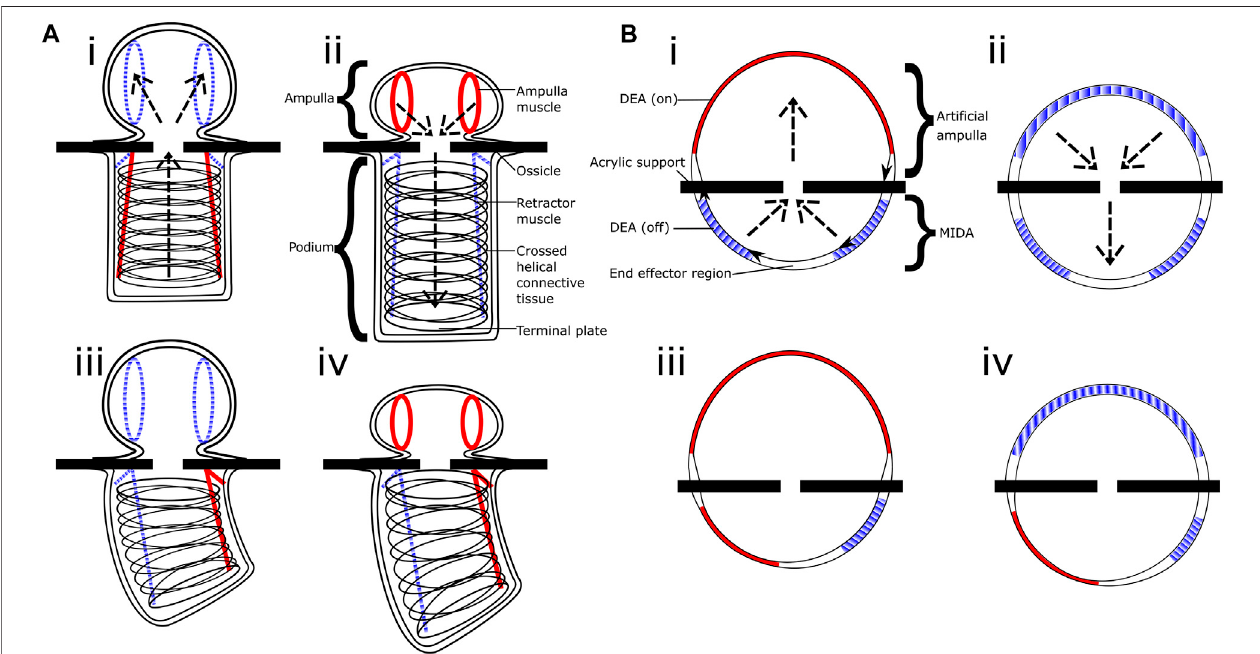
FIGURE5| Comparativediagram. (Ai – iv) showsthebasicstructureandmotionsofthetubefootof AsteriasRubens thecommonstar fi sh,whilst (Bi – iv) showsthe equivalent in our in fl ated actuator. Sections in red/solid are active muscles and DEAs, blue/striped are inactive, you can see the operation is inverted between the contracting biological muscle and our expanding arti fi cial muscles. The operations of the ampulla and arti fi cial ampulla are shown in fi gures (Ai – ii,Bi – ii) respectively, the arrows indicate the water/air fl ow.